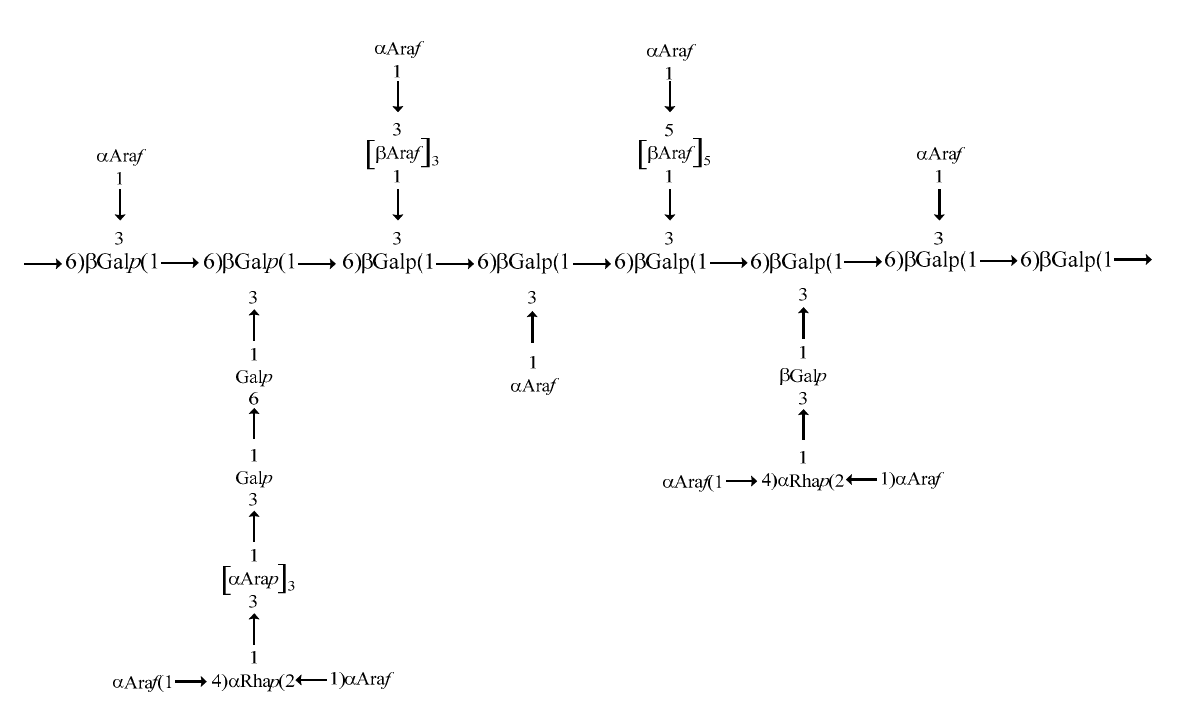
Figure 6. Possible structure of LBP-3.